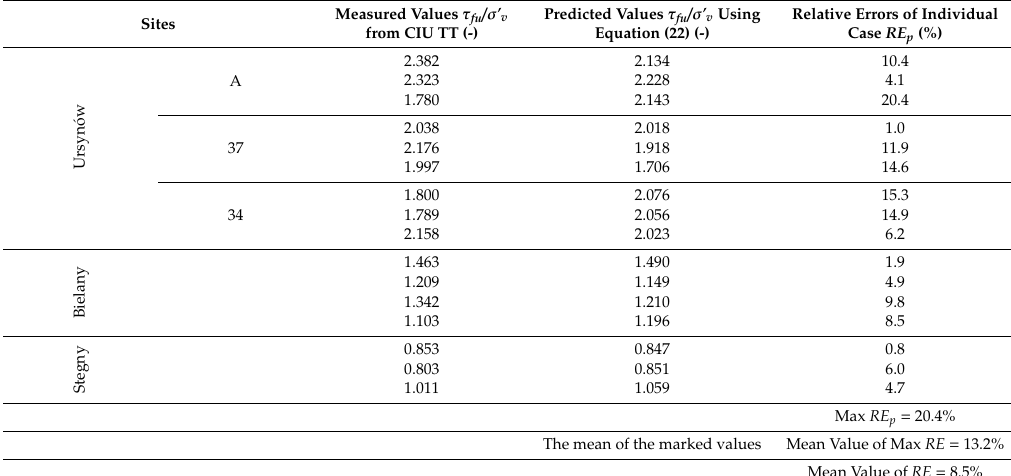
Table 8. Comparison between measured values of τ fu / σ ’ v obtained from the CIU triaxial tests and values of τ fu / σ ’ v predicted using the proposed relationship (Equation (22)). Bold number shows the maximum value of RE for given site τ fu / σ ’ v Predicted Values τ fu / σ ’ v Using Relative Errors of Individual Sites Measured Values from CIU TT (-) Equation (22) (-) Case RE p (%)